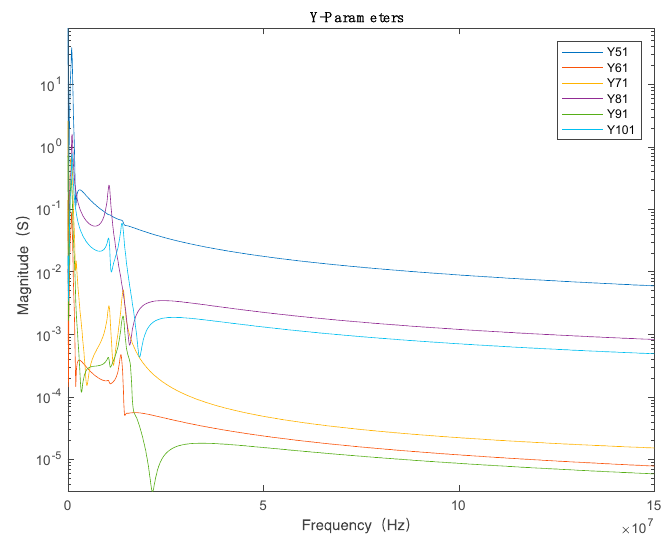
Figure 19. Y parameter simulation results between the Port 1 and other internal ports.